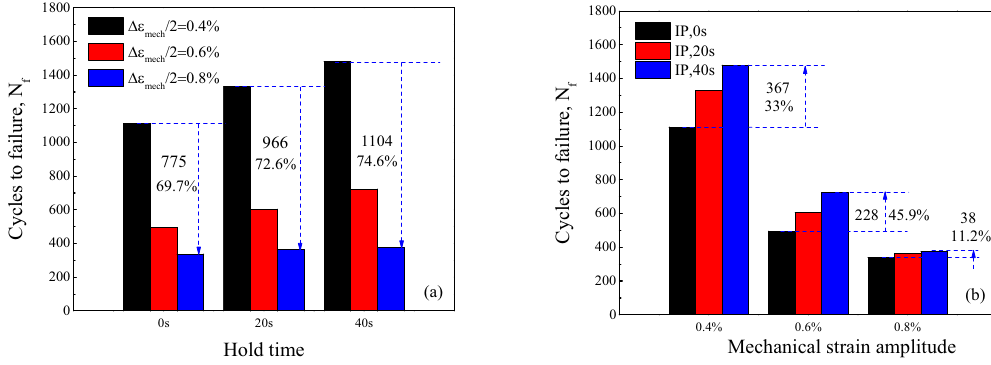
Figure 10: Comparison of the e ff ect on fatigue life of ( a ) strain amplitude and ( b ) hold